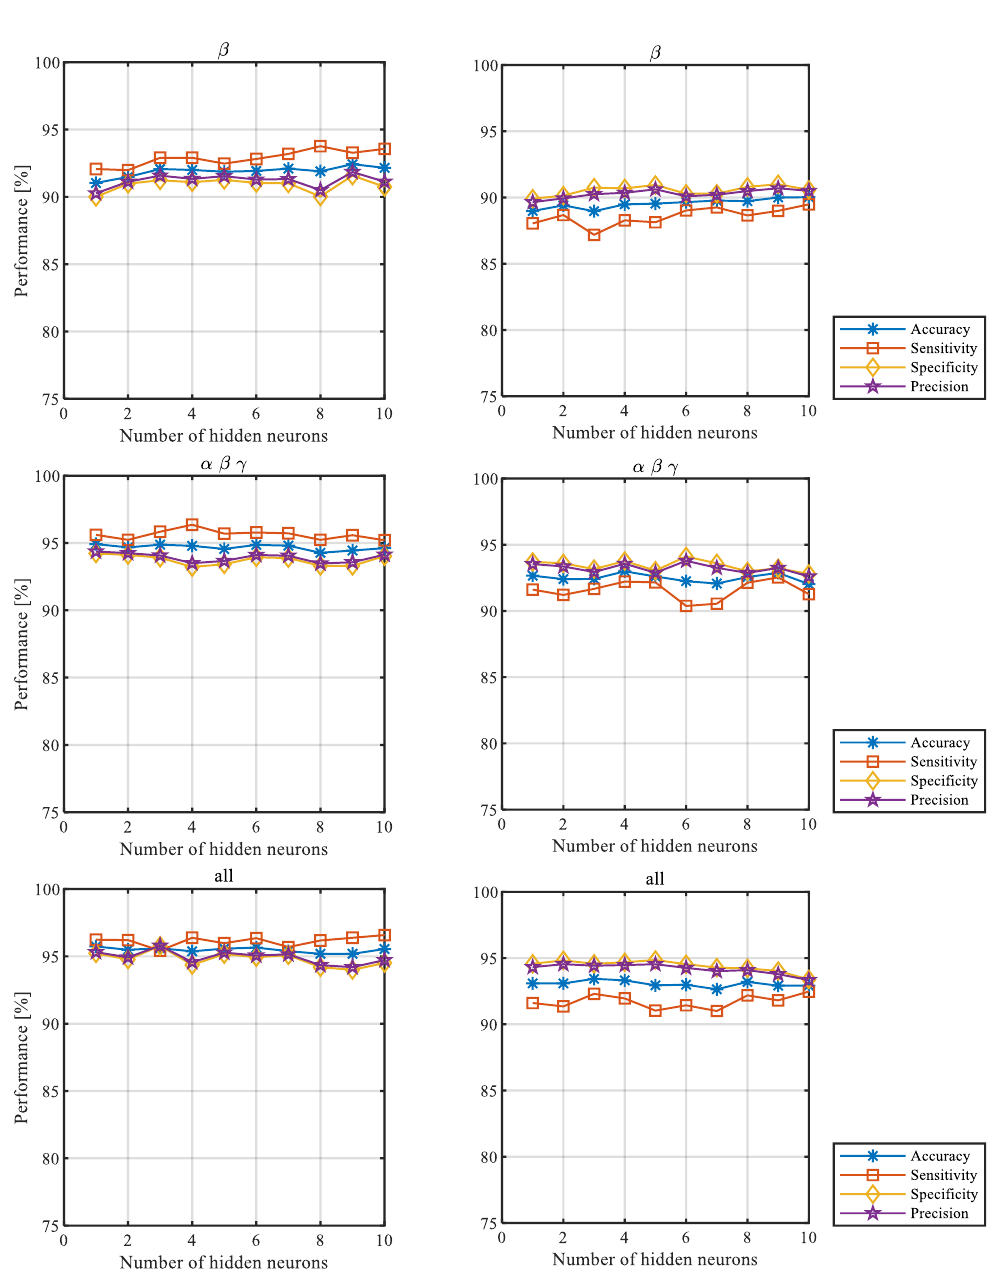
Figure 3. Network classification measures for selected frequency bands, where the training and testing feature set vectors were separated by different parts of the same sessions ( left , the first scenario) and different sessions ( right , the second scenario).